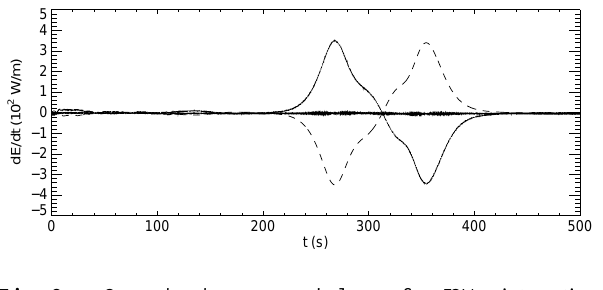
Fig. 6. Second-order energy balance for ISW interaction. Dots: d( ¯ E k2 + ¯ E a )/dt . Dashed: P = R R D u 0 w d their sum.